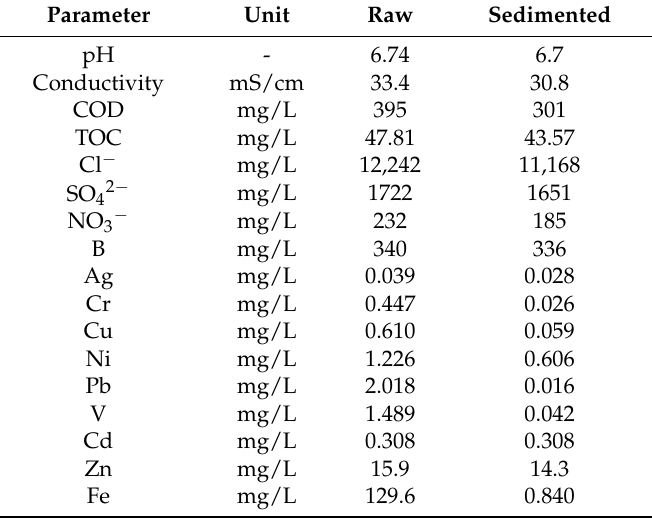
Table 1. Parameters determined in raw and sedimented FGD (flue gas desulphurization) wastewater and determination methods (COD: chemical oxygen demand; TOC: total organic